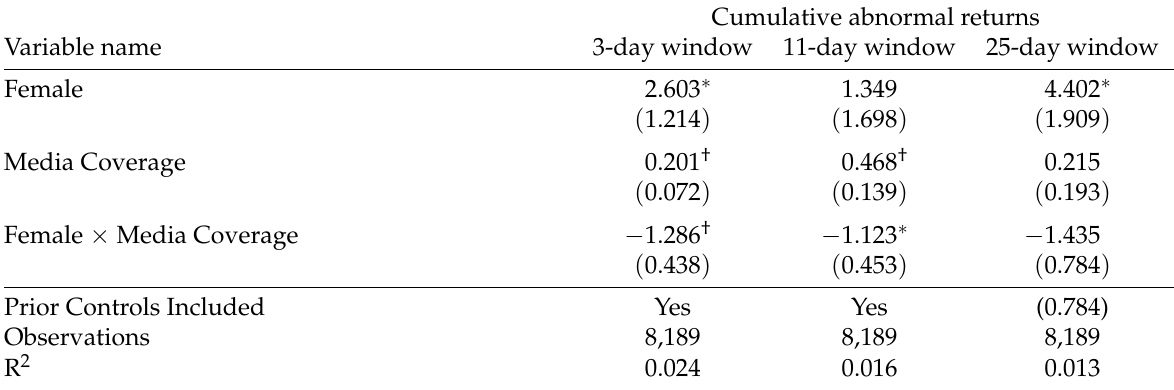
Table 6: Short-term versus long-term effects of media coverage and CEO gender on cumulative abnormal